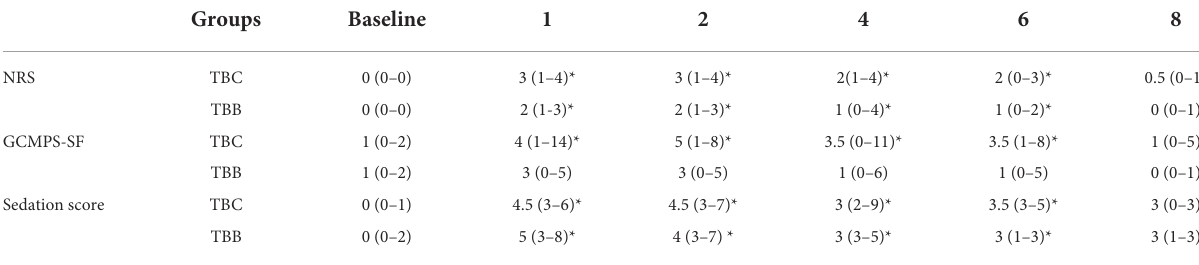
TABLE 3 Pain score and sedation score presented as median (minimum-maximum) of the 32 animals randomly distributed in the two study groups during the evaluated